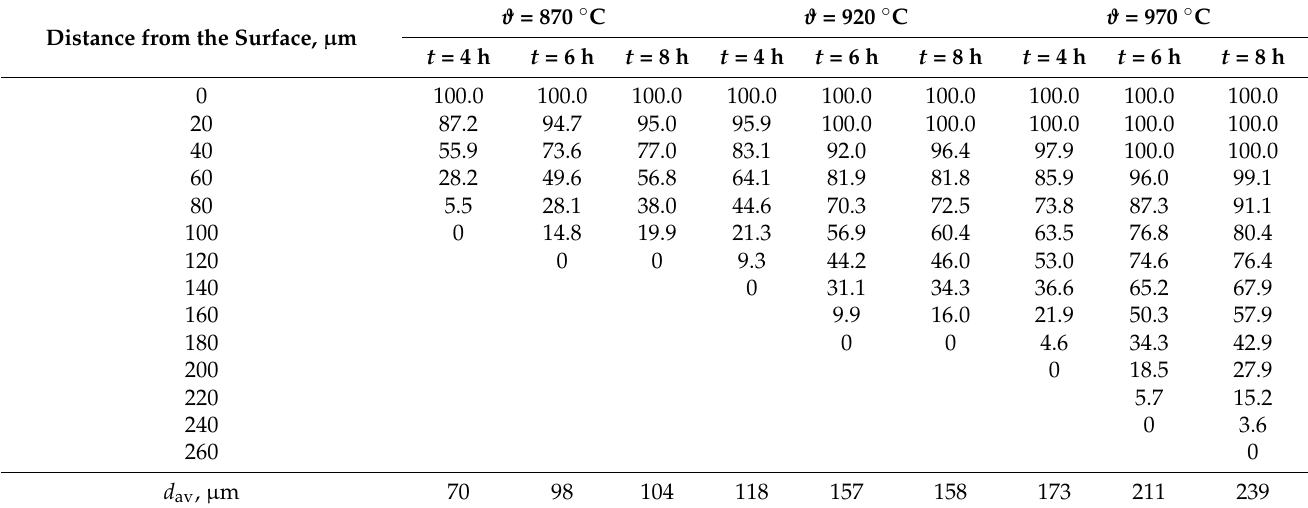
Table 11. Volume fraction of the boride phase for steel C15, %.